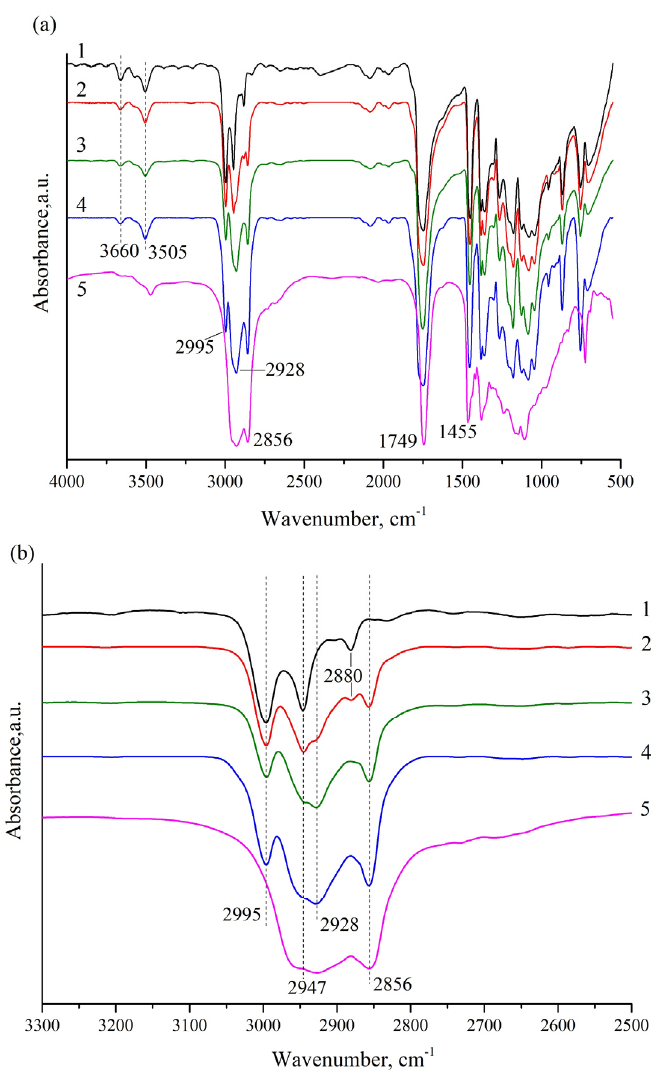
Figure 8. ( a ) FTIR spectra of the pristine PLA fiber mat (1), PLA + 1% OTOA (2), PLA + 3% OTOA (3), PLA + 5% OTOA (4), OTOA (5); ( b ) Close-up view of FTIR spectra in the vicinity of 3000 cm − 1 . Additional information on the interactions between PLA and OTOA can be